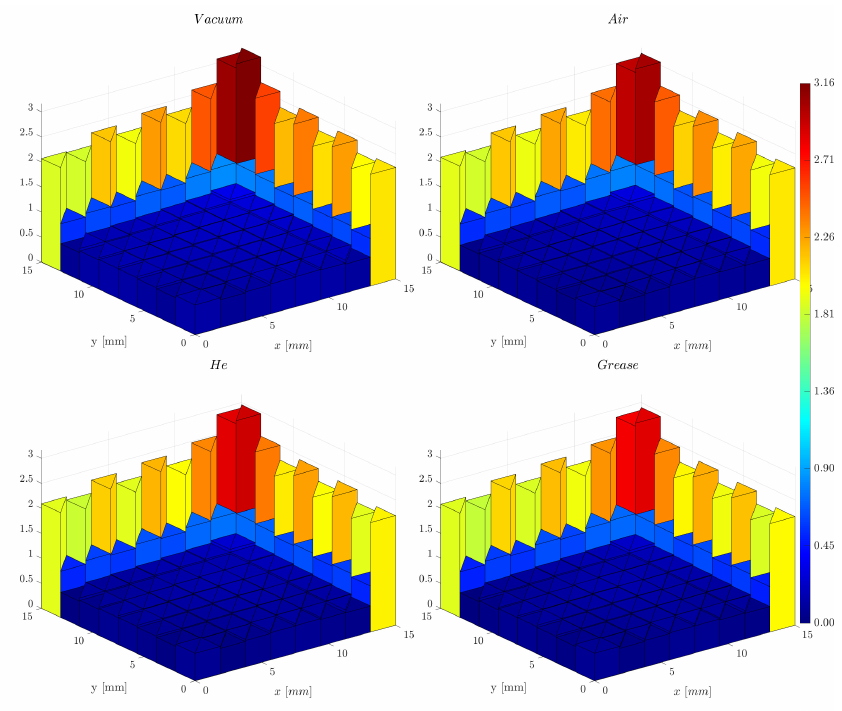
Figure A5. Complete normal traction distribution ( t n zone for all the TIMs analyzed.